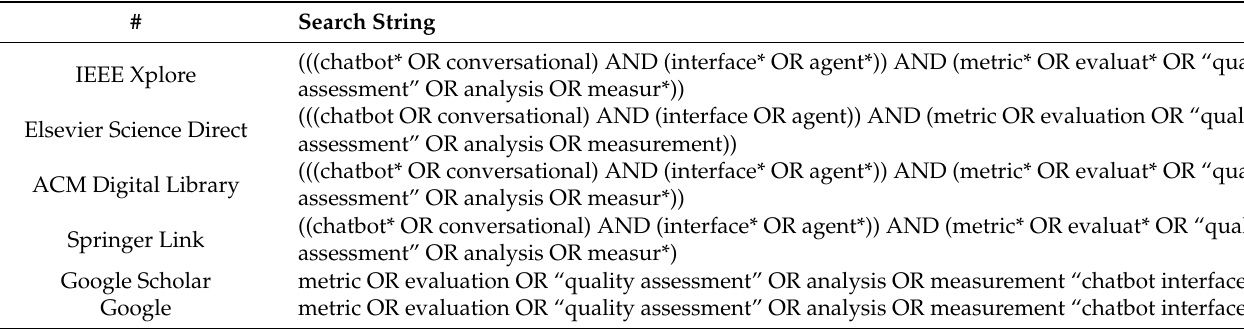
Table 3. Search string for research questions